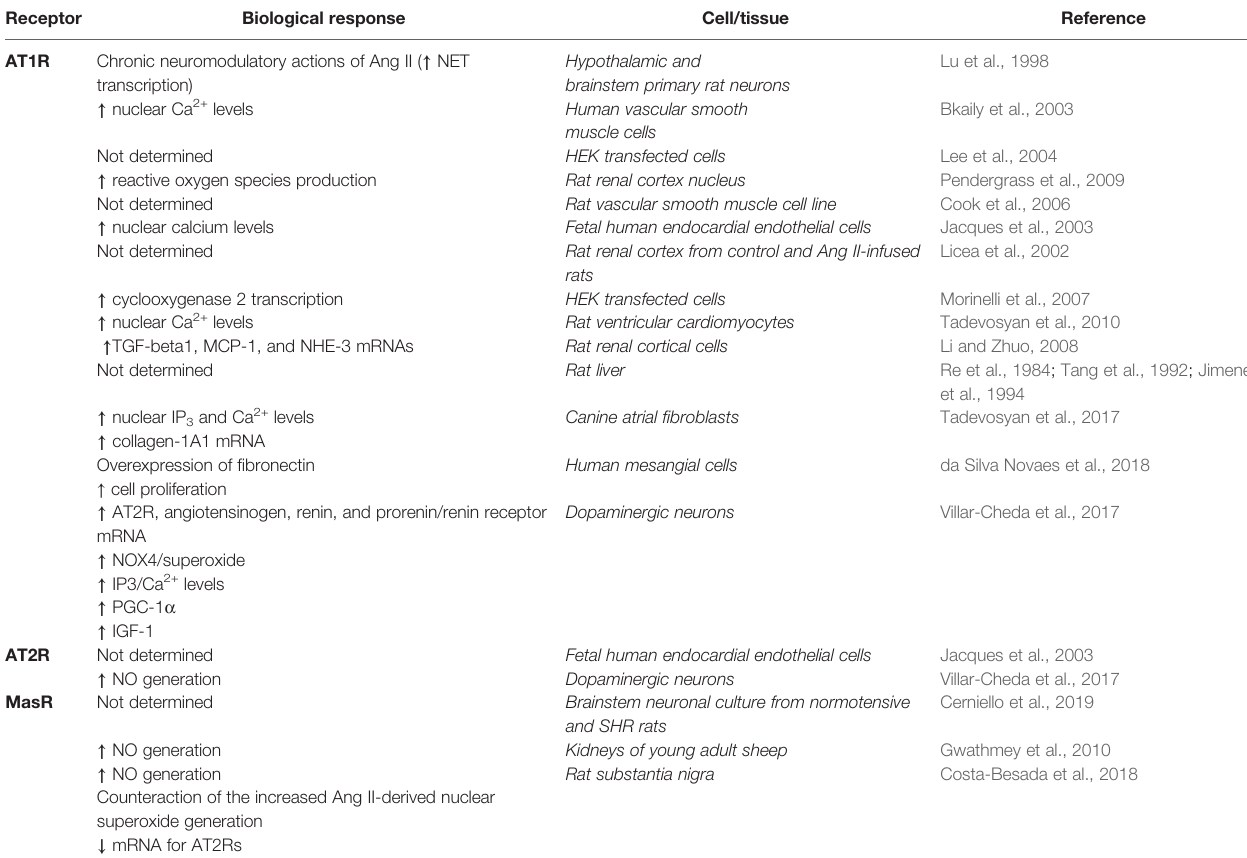
TABLE 5 | Nuclear angiotensin